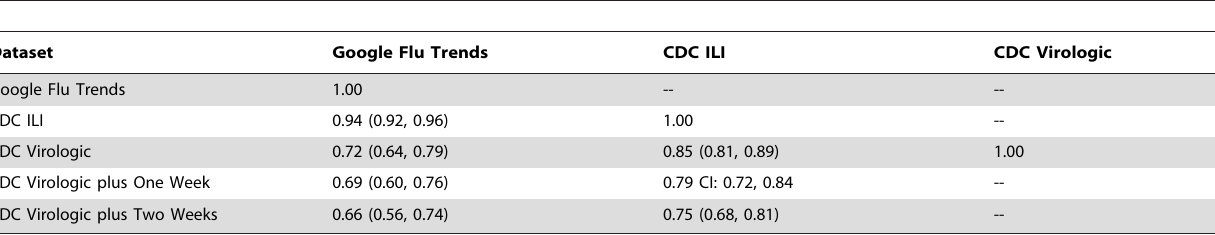
Table 1. Pearson’s Correlation Coefficient Matrix of Data from Three Influenza Surveillance Systems: Google Flu Trends, CDC